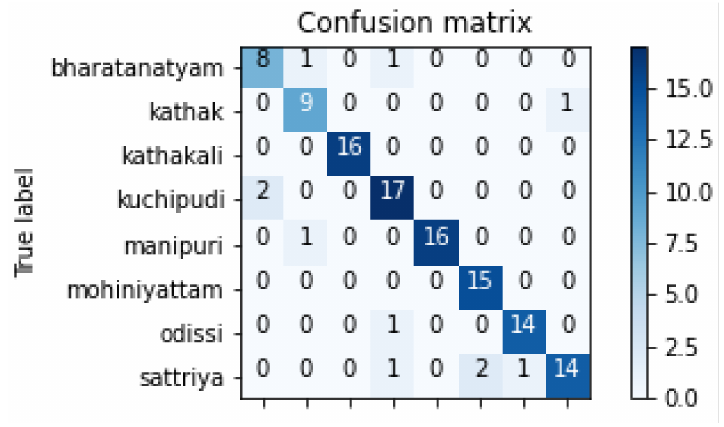
Figure 9. Confusion matrix for the proposed